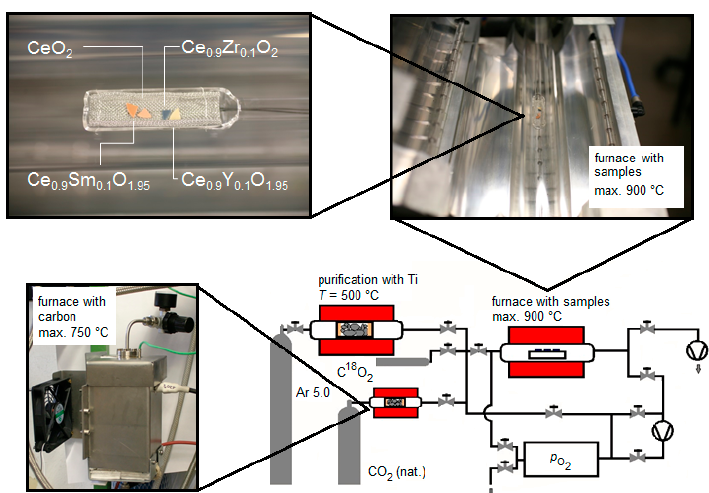
Figure 2. Overview display of the self-constructed experimental setup with an IR radiation heated furnace which allows fast heating rates up to 100 K/s in the temperature range between T = 300°C and T = 900°C. Further can be seen in the purification unit where the argon gas flow is reduced by a titanium sponge at T = 500°C, which enables oxygen partial pressures for the reduction step of p ≤ 10 -24 bar, as well as an additional carbon furnace which allows control of the CO:CO 2 ratio of the given gas mixture. The oxygen partial pressure was measured for all experiments in situ with a lambda probe (further details are given in the text). Table 2. Compilation of the experimental conditions and parameters as used in this